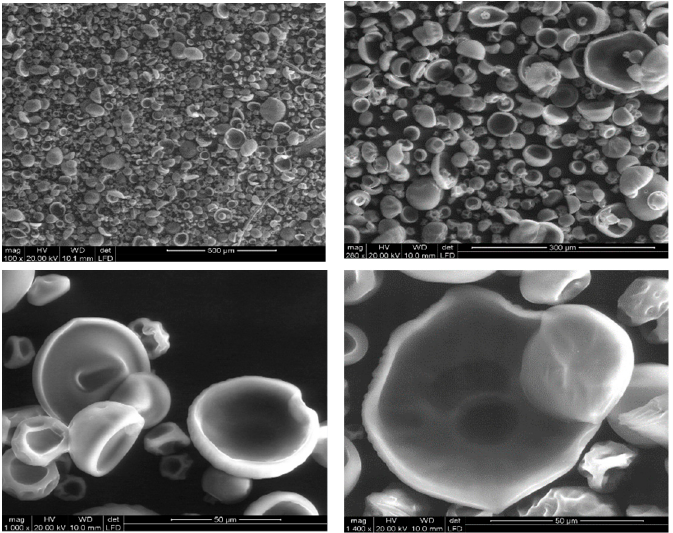
Figure 1. Micrographs of capsules prepared via immersion precipitation (IPS) technique.